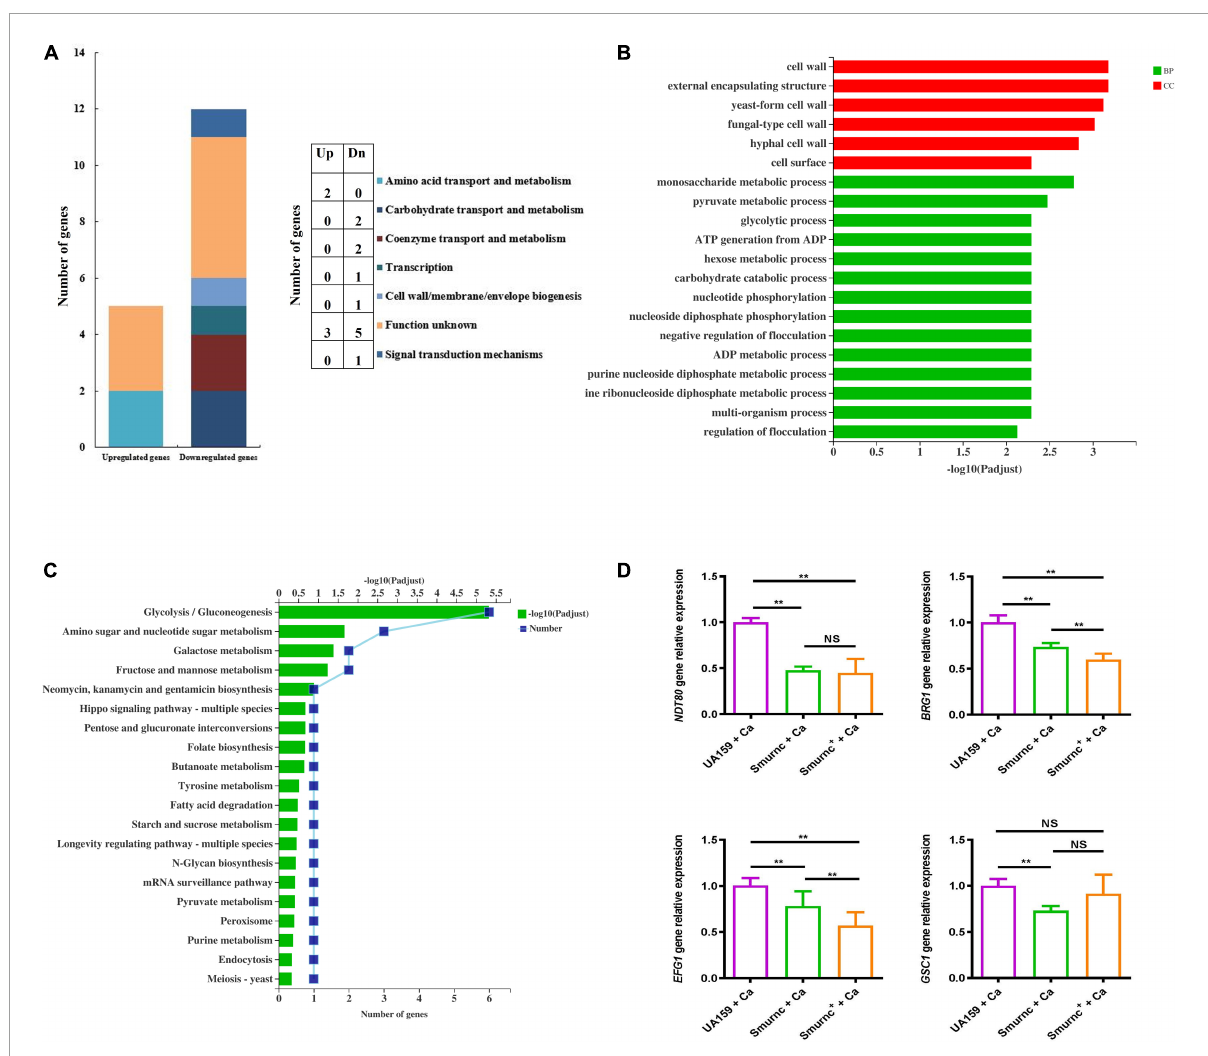
FIGURE6 rnc gene was associated with the gene expression of virulence factors of C. albicans . Transcriptomic analysis of the Smurnc + Ca group compared to the UA159 + Ca group. (A) The differently expressed genes were classified by gene annotation based on COG. (B) Functional categories and enrichment analysis of differently down-expressed genes based on GO. (C) Functional categories and enrichment analysis of differently down-expressed genes based on KEGG. (D) The gene transcripts of C. albicans in the cross-kingdom biofilms were relatively quantified by RT-qPCR using ACT1 as a reference gene and interpreted as fold changes based on the UA159 + Ca group. Experiments were performed in biological triplicate. ** P <